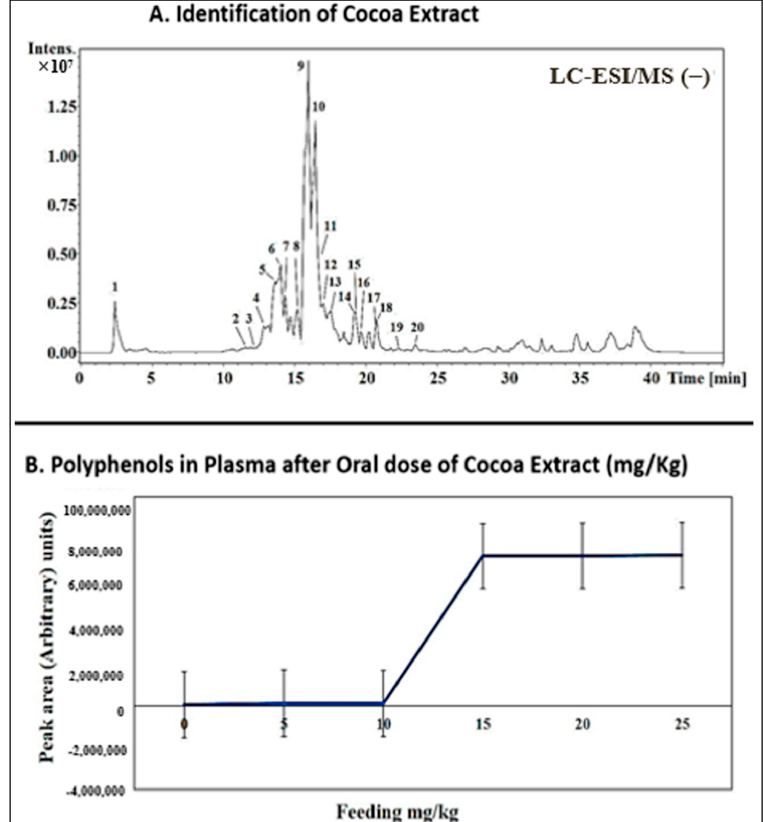
Figure 2. Cocoa Extract: ( A ) shows HPLC-ESI-MS graph with various peaks correlating with 19 di ff erent phenolic compounds found in cocoa extract. ( B ) shows a curve correlating di ff erent oral doses (mg / kg) of cocoa extract and blood levels of phenolic compounds in rats. It shows an optimal dose of 15 mg/kg to be the optimal dose of cocoa extract (six groups ( n = 30) and each group ( n = 5)). Antioxidants 2020 , 9 , x FOR PEER REVIEW